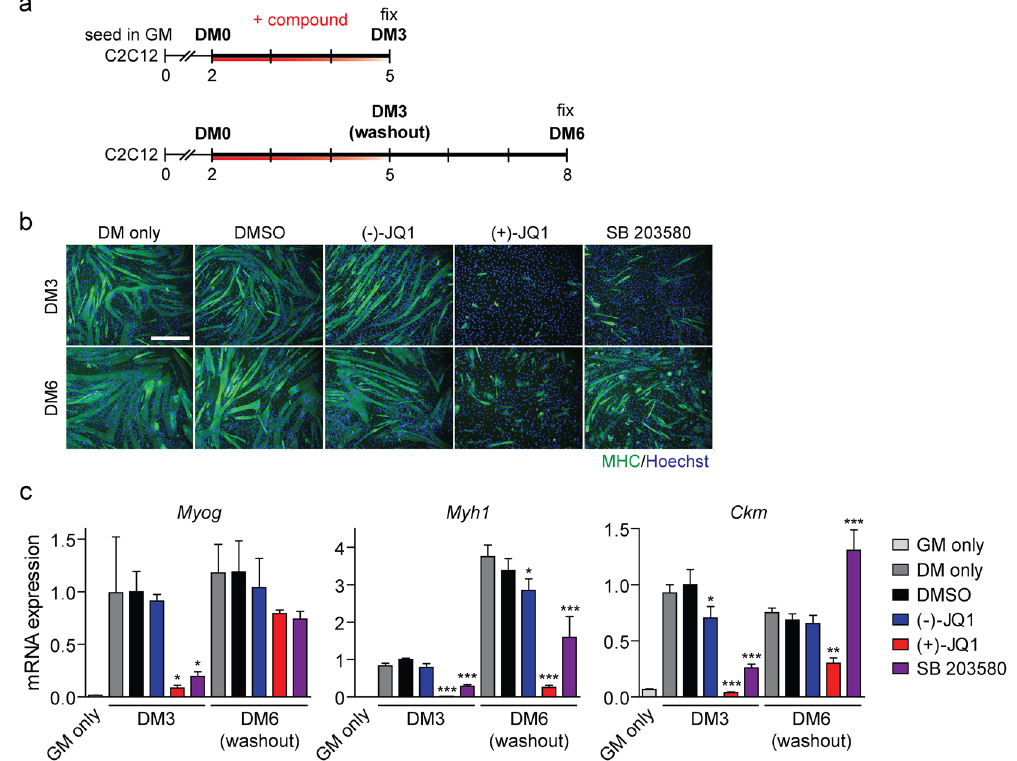
Figure 6. BETi treatment induces prolonged inhibition of myogenic differentiation in differentiation conditions. ( a ) C2C12 cells were treated with 1 µ M ( + )-JQ1 or 10 µ M SB 203580 for a 3 day period in DM and ( b ) cultures either fixed for MHC IF staining or cultured for an additional 3 days in fresh DM to washout the compounds before fixing. Myogenic differentiation was assessed relative to untreated (DM only), DMSO, and ( − )-JQ1 negative controls. ( c ) Myogenic transcript levels for Myog , Myh1 and Ckm were determined for each treatment protocol by RT-qPCR. Cells treated with GM only were included as an additional undifferentiated control. Images were taken at 10 × magnification, scale bars indicate 50 µ m. All values are mean + SD, n = 3, * P < 0.05, ** P < 0.01, *** P < 0.001. The mean of the DMSO group at day 5 was scaled to a value of one. Comparisons between multiple groups were tested using one-way ANOVA with Bonferroni post hoc test, and comparisons to the DMSO group